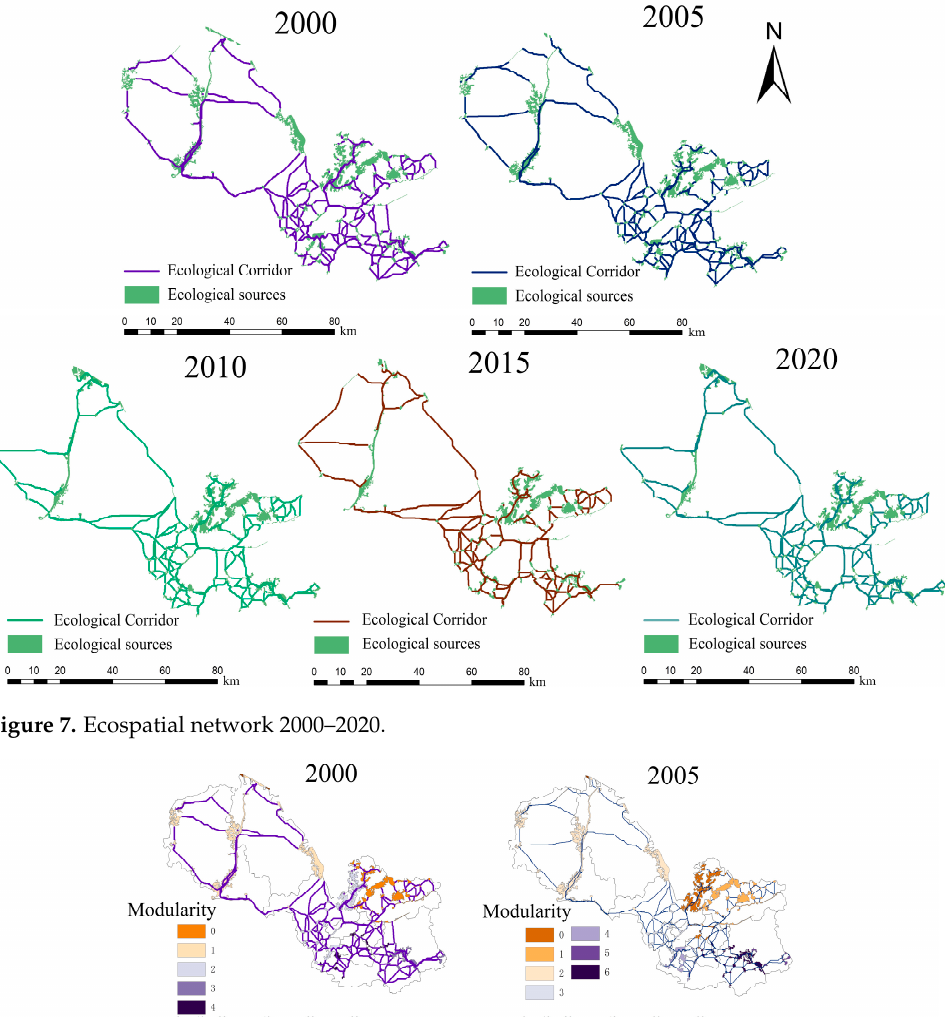
Figure 7. Ecospatial network 2000–2020.